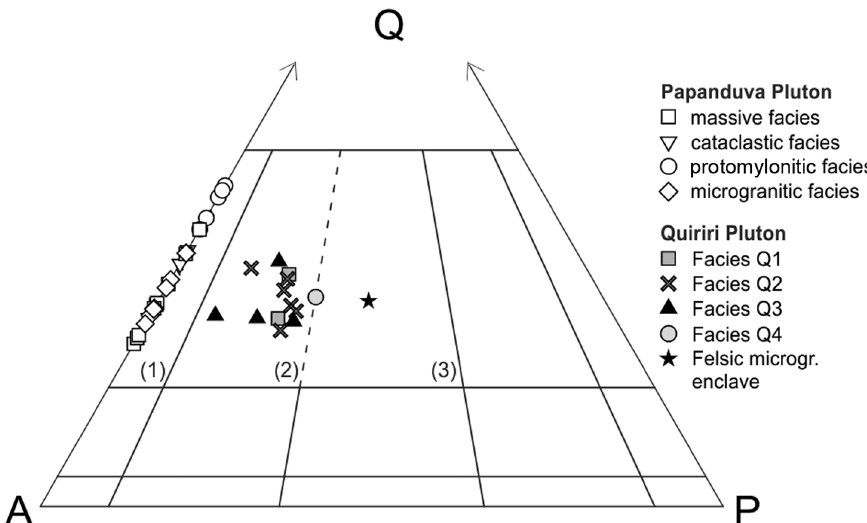
Figure 5 - Modal Quartz (Q) - Alkali Feldspar (F) - Plagioclase (P) diagram for oversaturated plutonic rocks according to Streckeisen (1976) showing compositional variations registered for the Papanduva and Quiriri Plutons, Morro Redondo Complex. Labeled fields are: (1) alkali- feldspar granite; (2) syenogranite and (3)